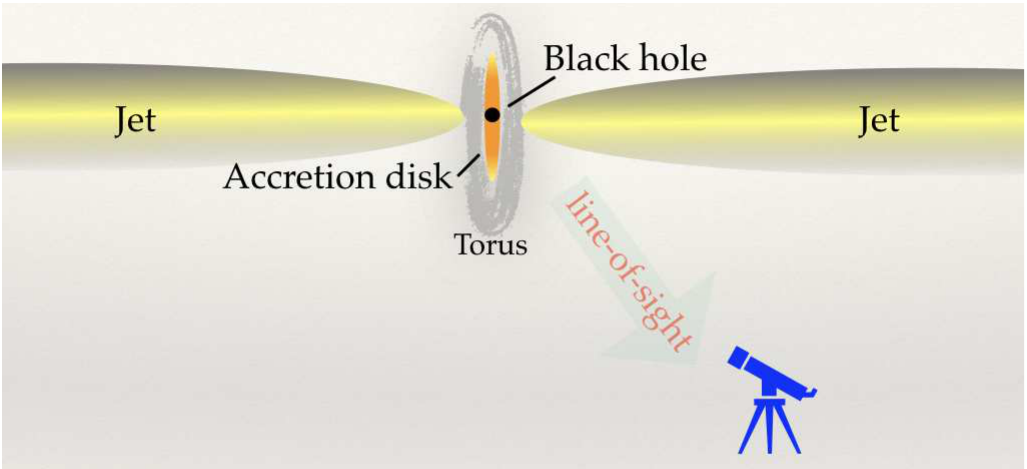
Figure 1. Sketch representing the mis-aligned radio emitting bipolar jets of a radio galaxy (not to scale). Jets typically extend up to a few hundreds of kilo-parsec to mega-parsec